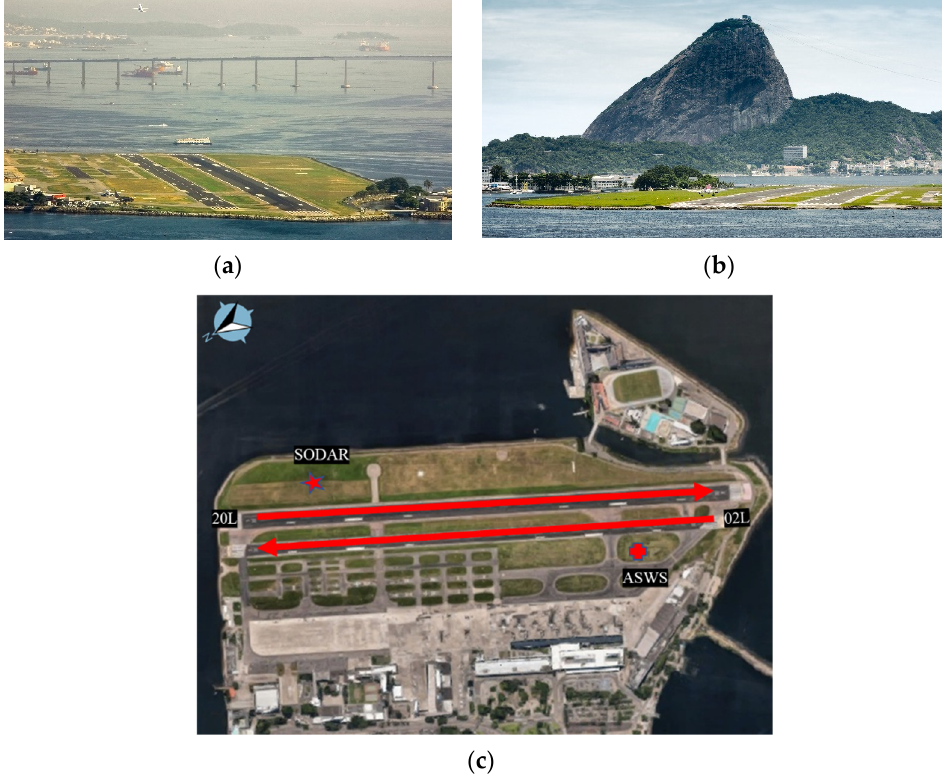
Figure 1. Views from the north ( a ) and south ( b ) directions for the SDA runways 02 and 20 (red arrows), SODAR (star) and the automatic surface weather station—ASWS (cross) are shown in ( c ). Source: Images used with permission from Shutterstock and the map is adapted from www.google.com.br/maps, accessed on 24 November 2021.